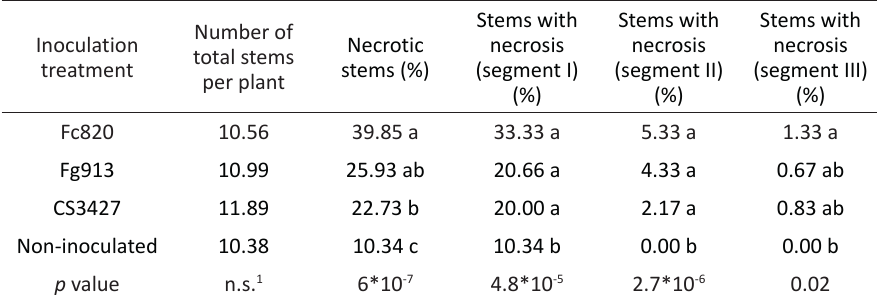
Table 1. Average values of the parameters assessed by visual observation of barley plants following stem-base inoculation with F. culmorum (Fc820), F. graminearum (Fg913) and F . pseudograminearum (CS427) and in the non-inoculated plants. p values indicate significant differences (Wald F tests for quasibinomial fit) if p ≤ 0.05, letters (a,b,c) indicate the statistical differences between treatments following generalized linear hypothesis testing (Bretz et al.